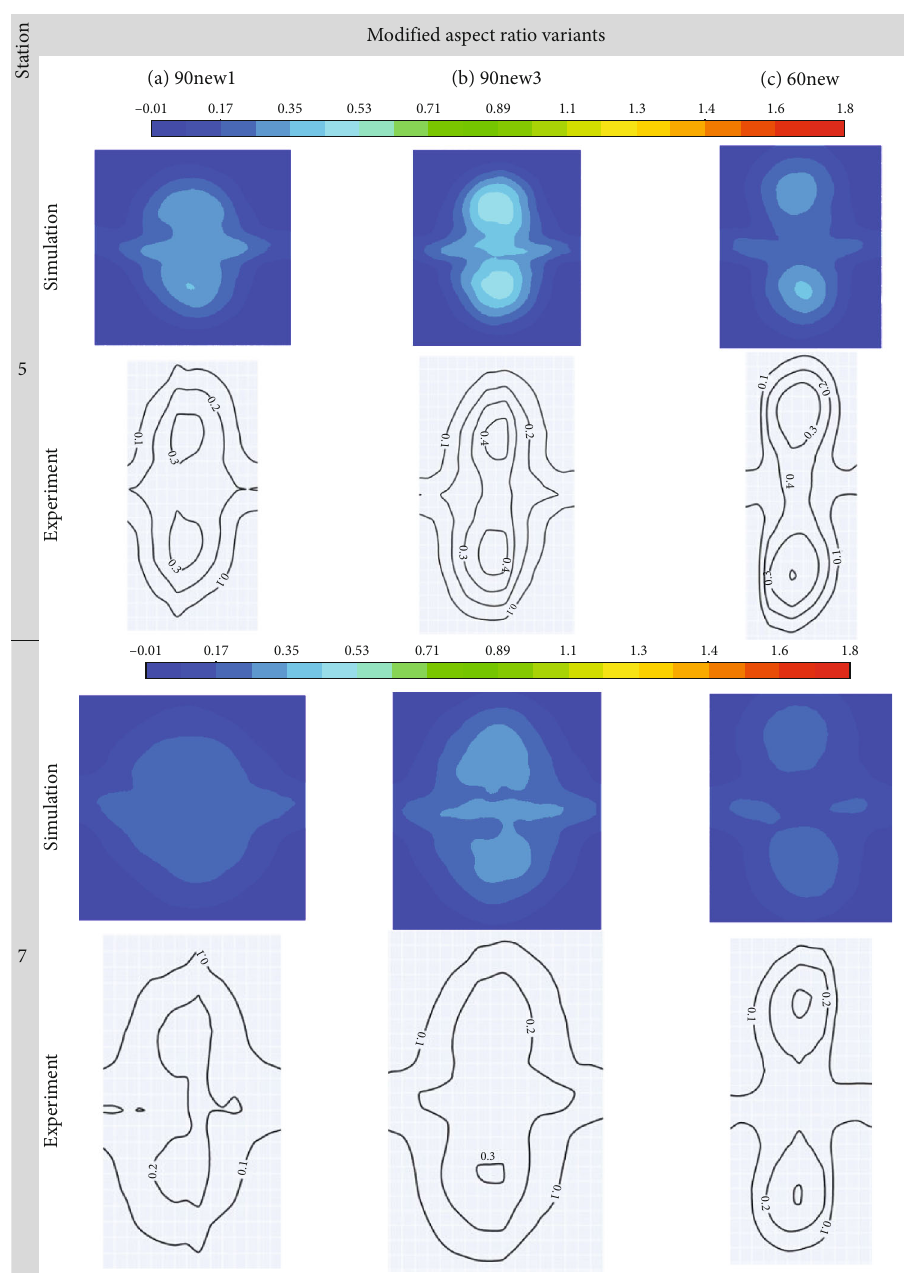
Figure 8: Comparison of wind tunnel and simulation results for cp distribution at stations 5 and 7 for 3 modi fi ed aspect ratio variants (a) 90new1, (b) 90new3, and (c)